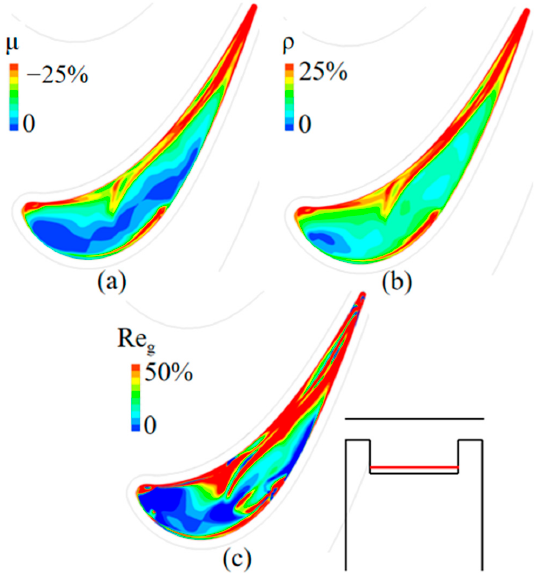
Figure 5. Percentage change in fluid properties near the squealer cavity floor surface (location indicated by the red line, 1% Cz off the cavity floor): ( a ) dynamic viscosity, ( b ) density, ( c ) percentage difference distribution of Re g .